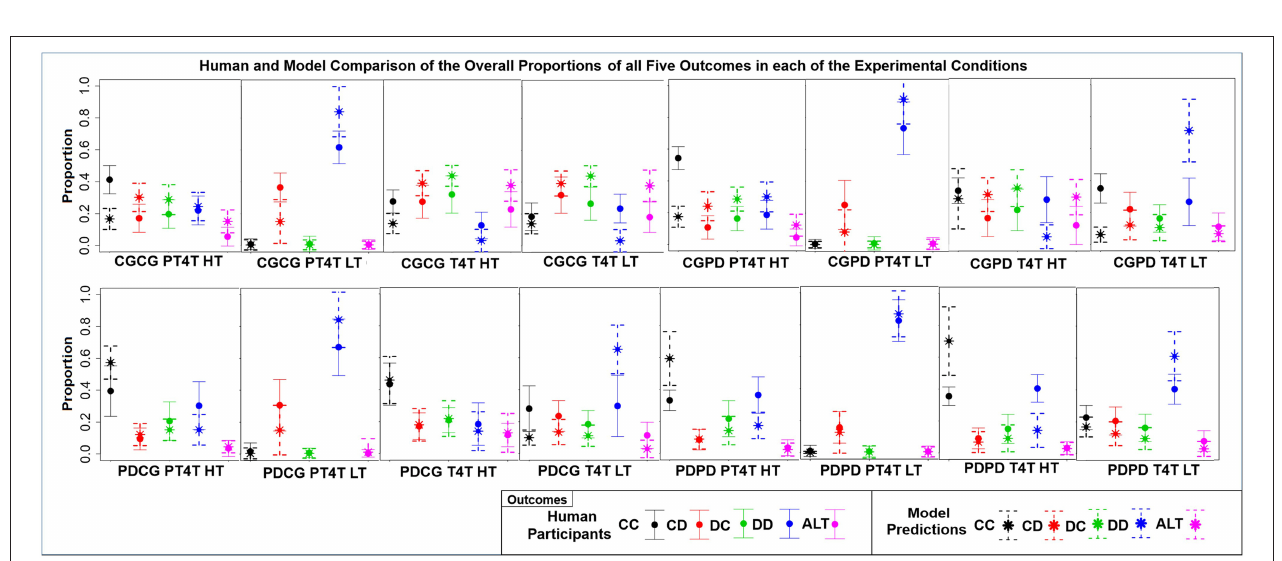
FIGURE 4 | The mean and standard error of the mean of the participants’ state trust. Participants were found to have more trust in the high (HT) than the low (LT) trustworthiness agent and the Tit-for-Tat (T4T) than the Pavlov-Tit-For-Tat (PT4T) strategy.